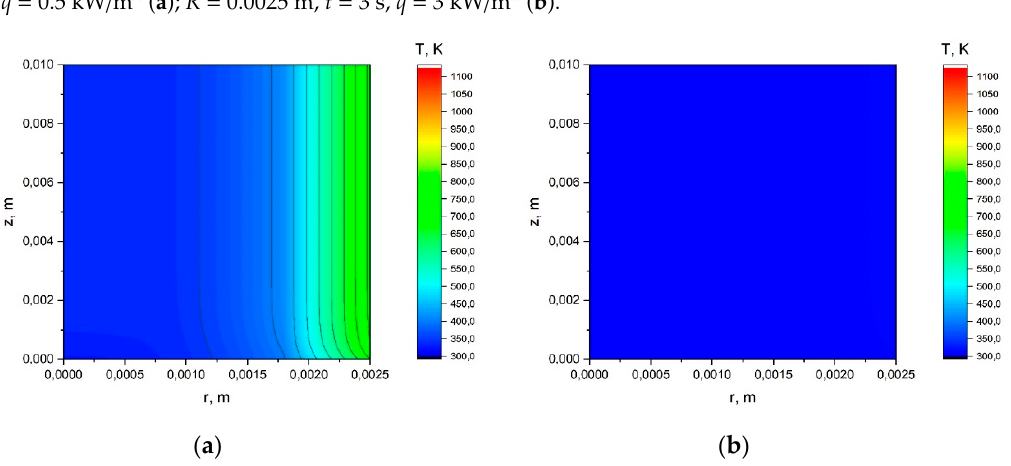
Figure A8. Temperature distribution in the stem of a herbaceous plant: R = 0.0025 m, t = 3 s, q = 30 kW/m 2 ( a ); R = 0.0025 m, t = 6 s, q = 0.5 kW/m 2 ( b ).